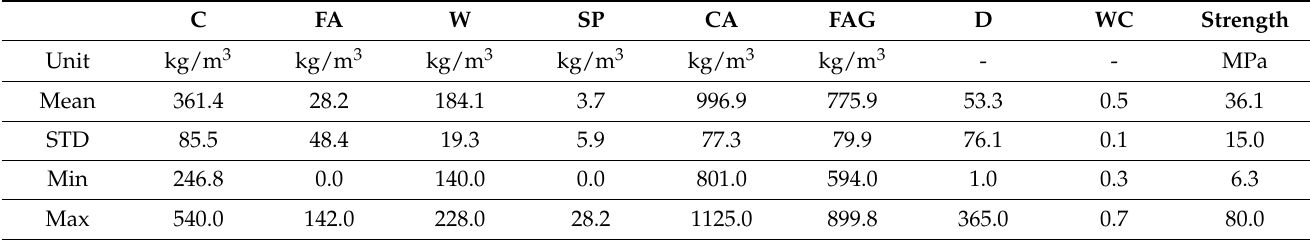
Table 1. Characteristics of